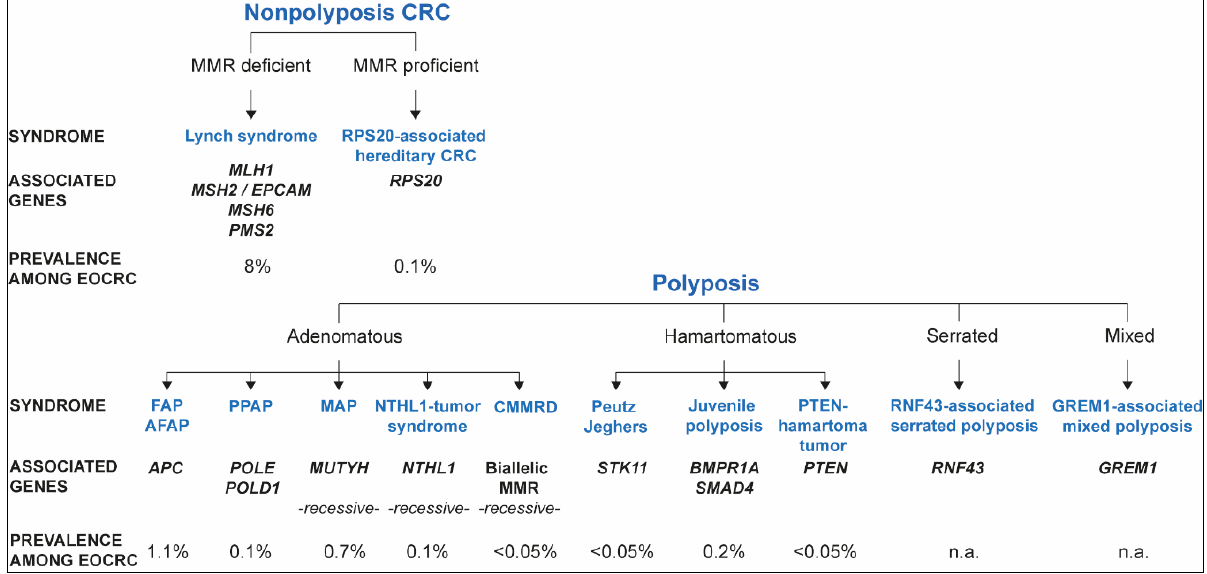
Figure 1. Hereditary colorectal cancer (CRC) syndromes, associated phenotypes, causal genes, and contribution to EOCRC.